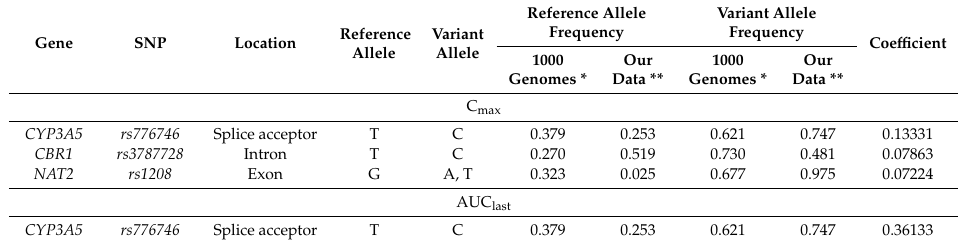
Table 3. Genetic variants with a coe ffi cient > 0 for tacrolimus C max and AUC last in the least absolute shrinkage and selection operator (LASSO) models.